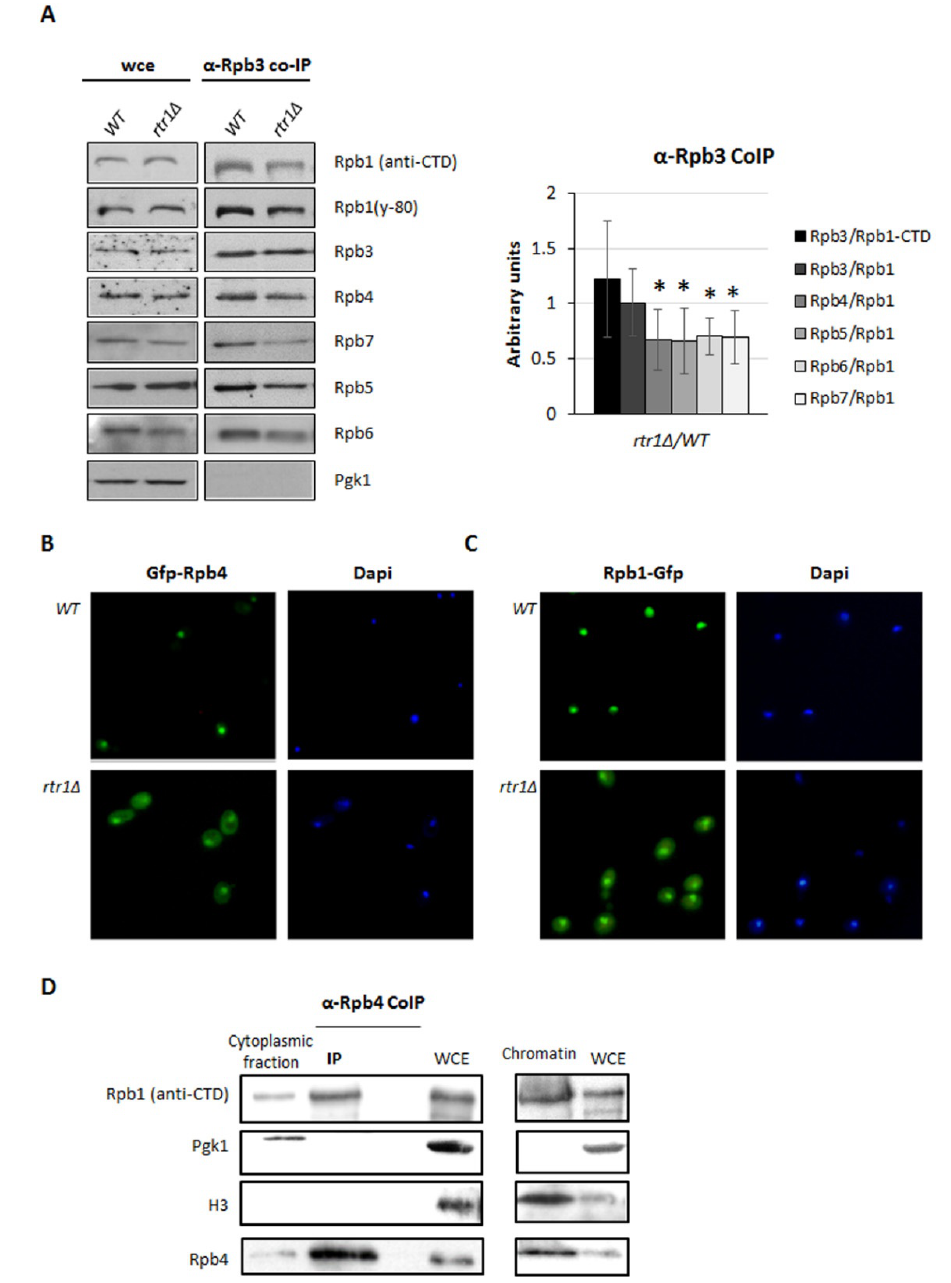
Figure 4. RTR1 deletion affects assembly of RNA pol II. ( A ) RNA pol II immunoprecipitated from wild-type and rtr1 ∆ mutant strains using an anti-Rpb3 antibody and grown in YPD medium at 30 ◦ C. Upper panel shows Western blot analysis of subunits Rpb1 (anti-CTD and y-80 antibodies),